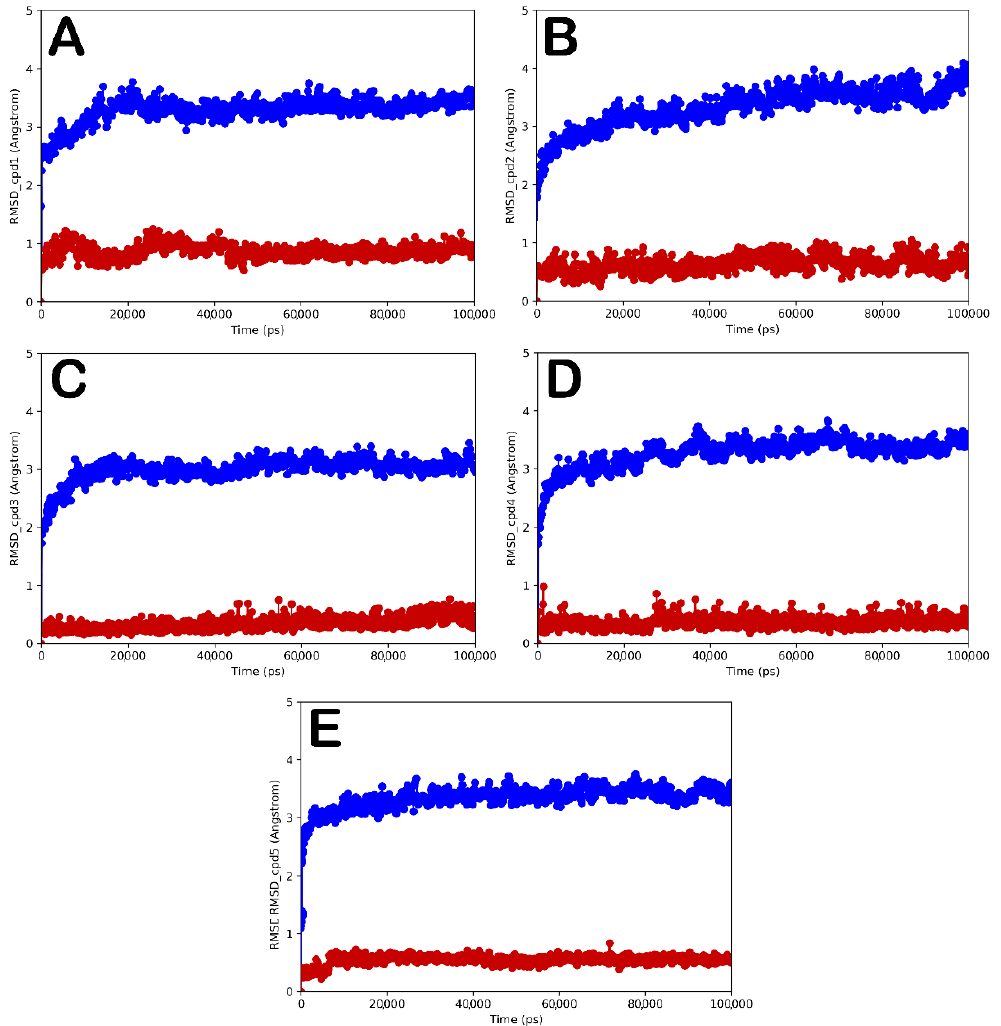
Figure 3. RMSD calculation for each complex and for each ligand. RdRp/compounds 1 – 5 , panel A – E (blue line), respectively. Compounds 1 – 5 , panel A – E (red line), respectively.